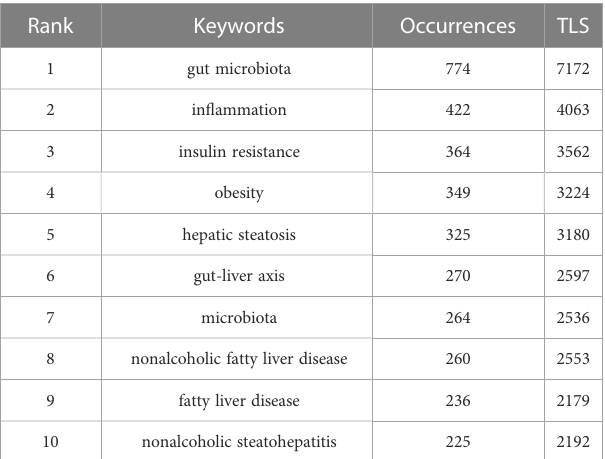
TABLE 7 Top 10 keywords in terms of frequency in the gut-liver axis in